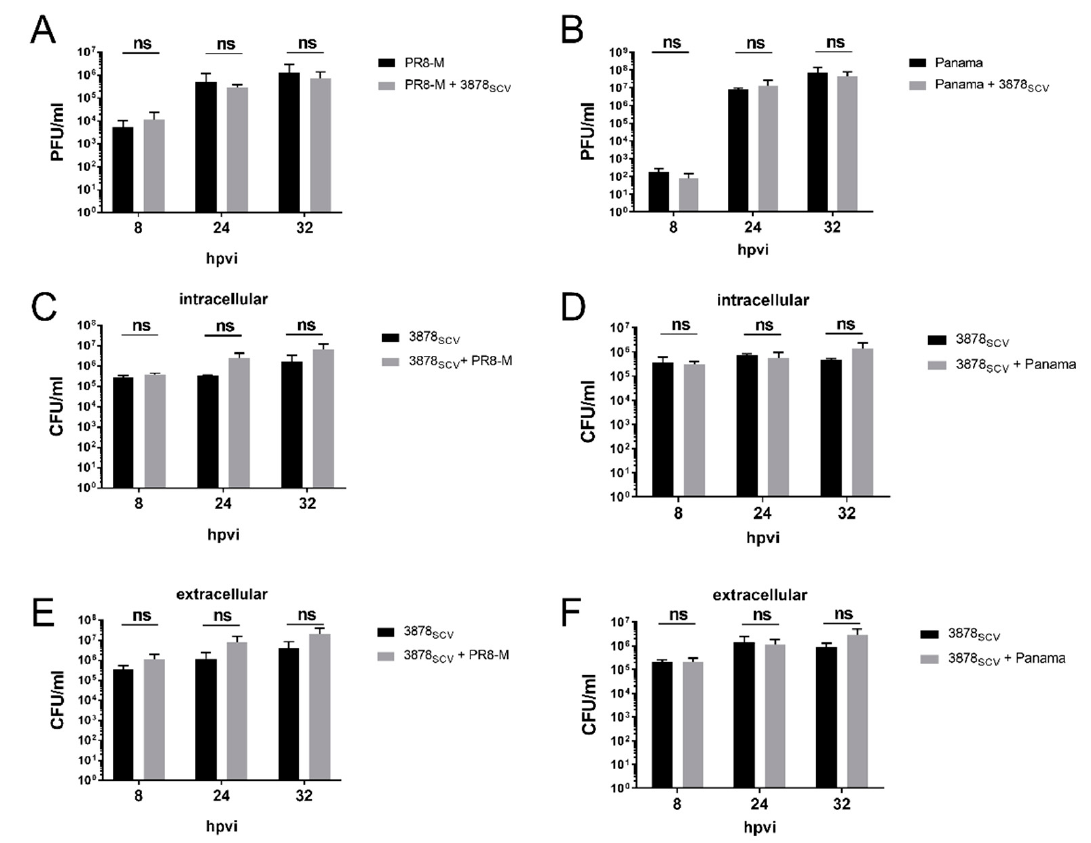
Figure 2. Pathogen load is not a ff ected during S. aureus 3878 SCV colonization and subsequent influenza virus infection. A549 human lung epithelial cells were infected with S. aureus 3878 SCV (MOI = 0.01) for 24 h and / or super-infected with ( A , C , E ) IV PR8-M (H1N1; MOI = 0.1) or ( B , D , F ) IV Panama (H3N2; MOI = 0.01) for 8 hpvi, 24 hpvi, or 32 hpvi. At the indicated times post-viral infection, supernatants were collected to determine viral and extracellular bacterial titers. Afterwards, cells were lysed via hypotonic shock to analyze intracellular bacterial titers. Means + SD of three independent experiments with technical duplicates are shown ( n = 3). Statistical significance (compared to single-IV infection ( A , B ) or single-bacteria infection ( C – F ) was analyzed by a two-way ANOVA, followed by Sidak’s multiple comparison test; (hpvi = hours post-viral infection; ns = not